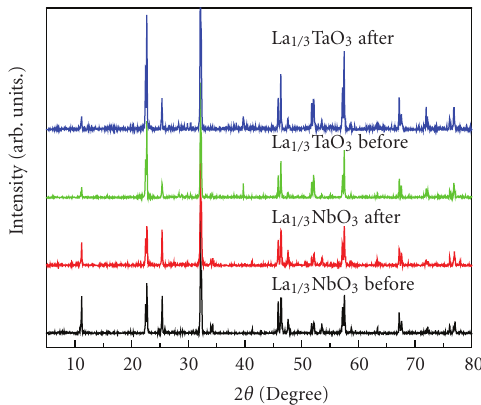
Figure 1: Powder X-ray di ff raction patterns of the La 1 / 3 MO 3 (M = Nb, Ta) powders before and after photocatalytic reaction of H 2 evo- lution from aqueous methanol solution dispersed with the 0.5 wt% Pt-loaded La 1 / 3 MO 3 (M = Nb, Ta) powder (0.5g) catalysts under UV light irradiation. Light source: a 400 W high-pressure Hg